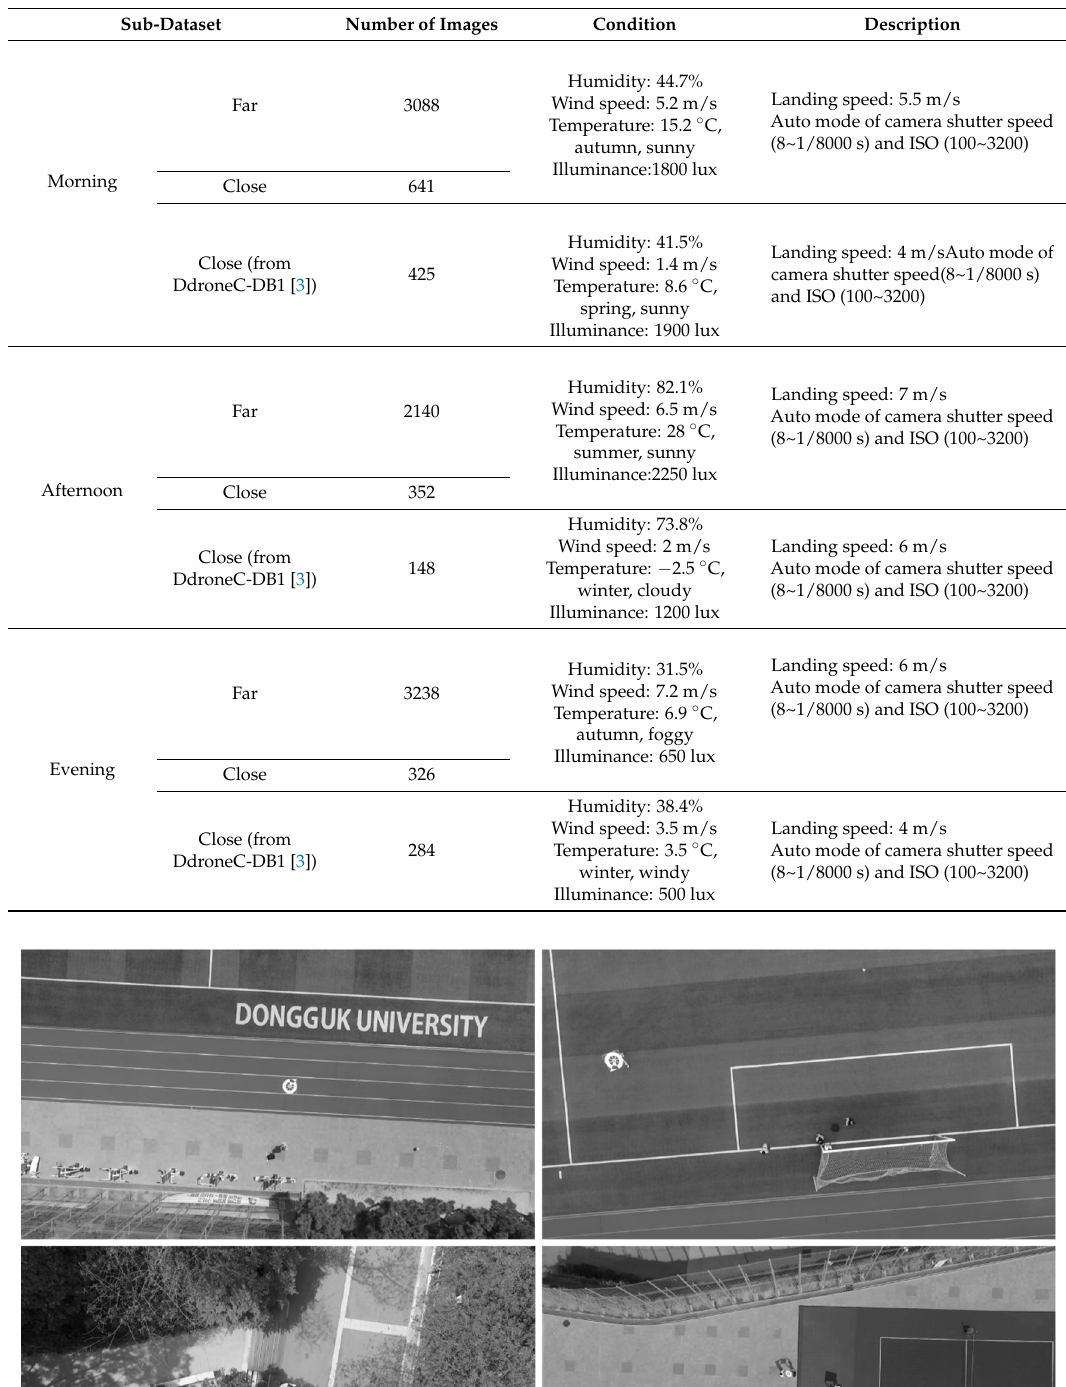
Table 5. Description of DDroneC-DB2.